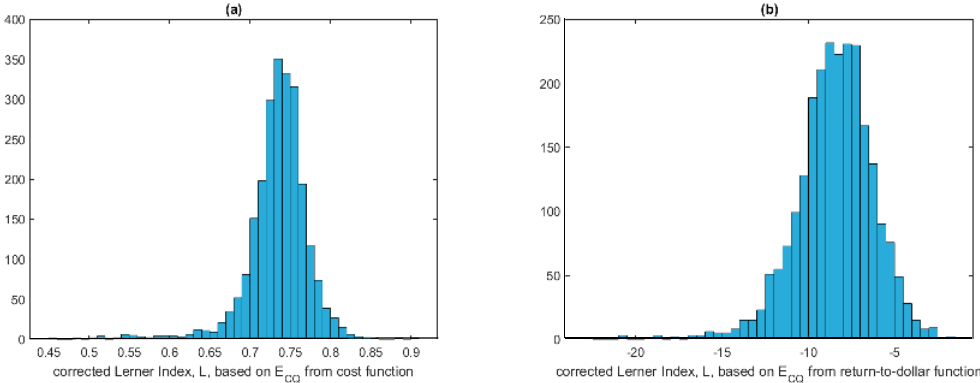
Figure 2. Corrected Lerner indices.